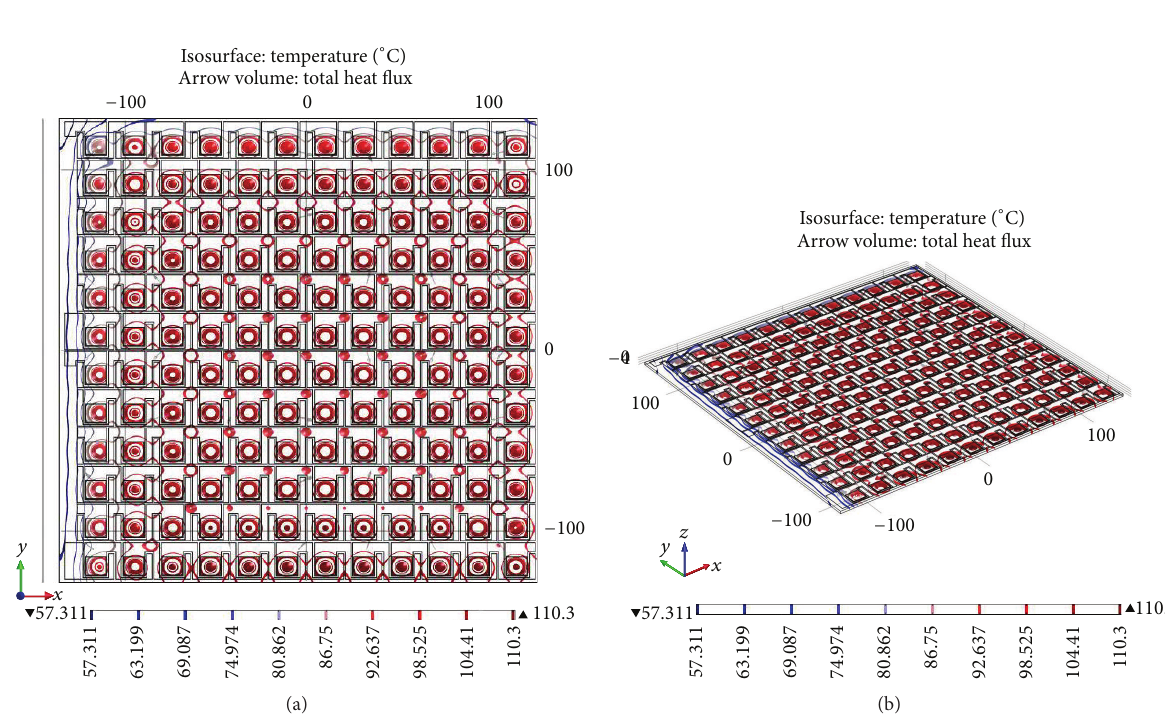
Figure 10: Front view (a) and lateral view (b) of the isothermal contours of the full scaled board in the worst case conditions in ∘